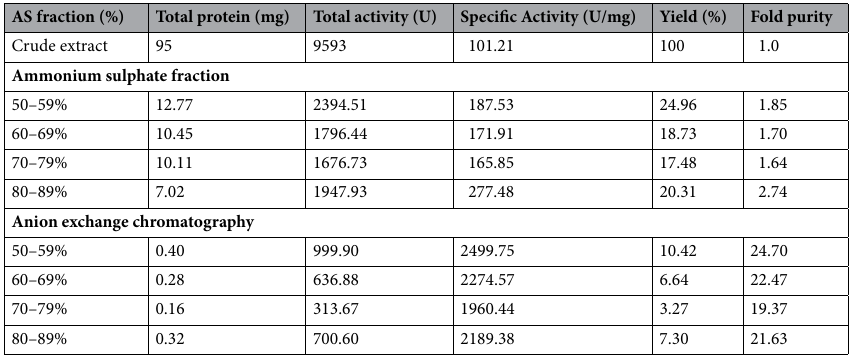
Table 8. Purification table for xylanase from Trichoderma harzianum strain.